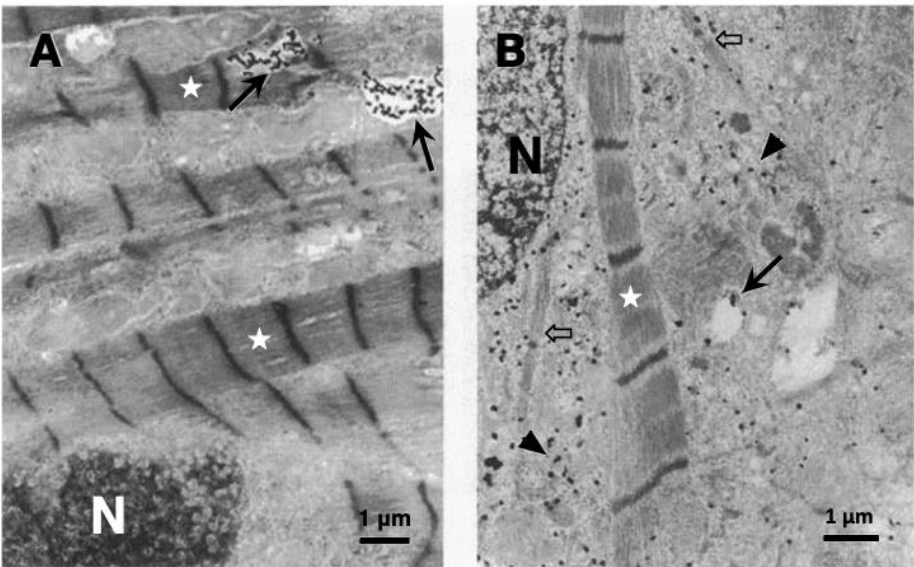
Figure 1. Immunoelectron microphotographs of rat heart myocytes showing immunoreactivity of cathepsin D. The control cell ( A ) shows that cathepsin-positive immunogold particles are localized within lysosomes (( A ) arrows). In contrast, the cell exposed to 5 µ mol/L naphthazarin for 30 min shows leakage of gold particles from the lysosomes into the cytoplasm (( B ) arrow heads). The oxida- tive stress caused a remarkable loss of myofilaments (( A , B ) stars) presumably by the extra-lysosomal release of cathepsin enzymes. Dissolving myofilaments (( B ) open arrows) are surrounded by aggre- gated immunogold particles labelling cathepsin D. Lysosomes after the leakage of contents (( B ) arrow) show a marked loss of immunogold particles, compared to those of the control (( A ) arrows). This is evidence of lysosomal membrane permeabilization/rupture. N; nucleus. (Adapted from